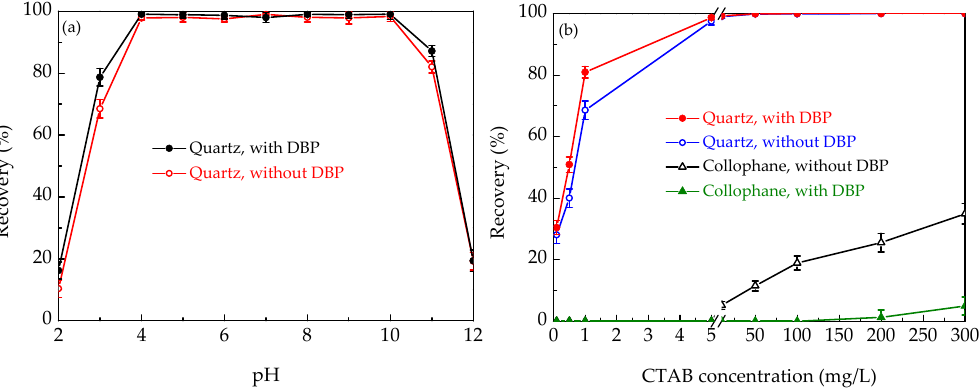
Figure 2. Recovery as a function of pH at CTAB concentration of 5.0 mg/L ( a ) and as a function of CTAB concentration at pH 6.0 ( b ) for systems with and without DBP.